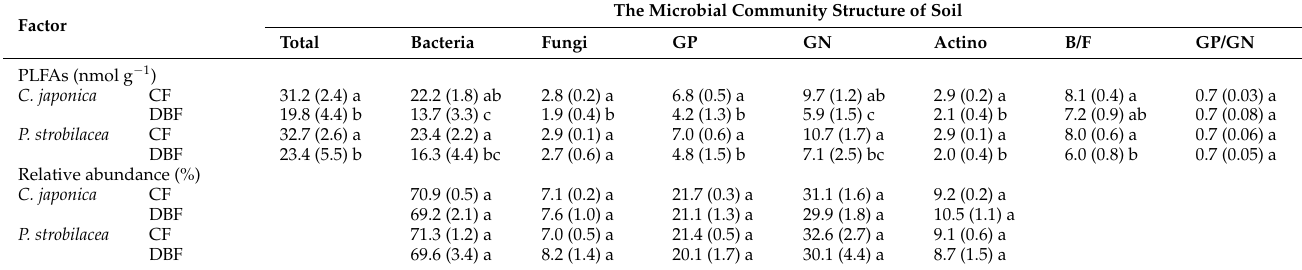
Table 6. The soil microbial PLFAs (nmol g − 1 ) and relative abundance (%) ( n = 3. means ± 1 se) under the CWD of two tree types ( C. japonica vs. P. strobilacea ) in the two habitats (CF vs. DBF) after decomposition. Different lowercase letters indicate significant differences ( p < 0.05). CWD: coarse woody debris; CF: coniferous forest; DBF: deciduous broadleaf forest. Total: total PLFA; Actino: actinomycete; B/F: the ratio of bacteria to fungi; GP/GN: the ratio of GP to GN.